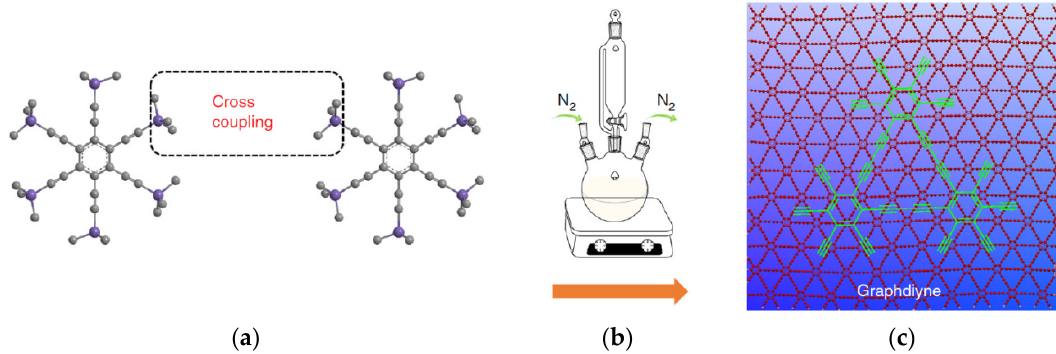
Figure 19. Formation of the flat graphdiyne network: ( a ) synthesis schematic; ( b ) principal setup of the synthesis; ( c ) ideal graphdiyne layer structure. Reproduced from [49] with permission from Springer Nature. Copyright 2018.